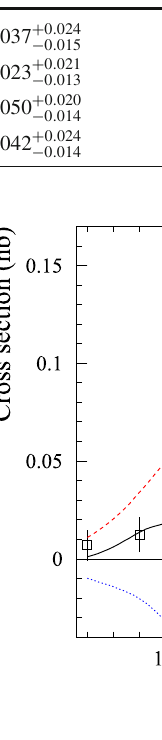
Fig. 12 The cross section of the process e + e − → φπ 0 → K + K − π 0 obtainedinthisworkandintheBABARexperiment[3].Thesolidcurve is the result of the fit to the cross section data with Eq. (6). The dashed and dotted curves represent the σ φπ 0 term and the interference terms of Eq. (6), respectively